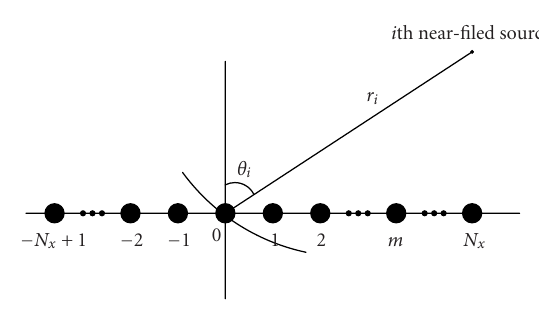
Figure 1: Sensor configuration of near-field